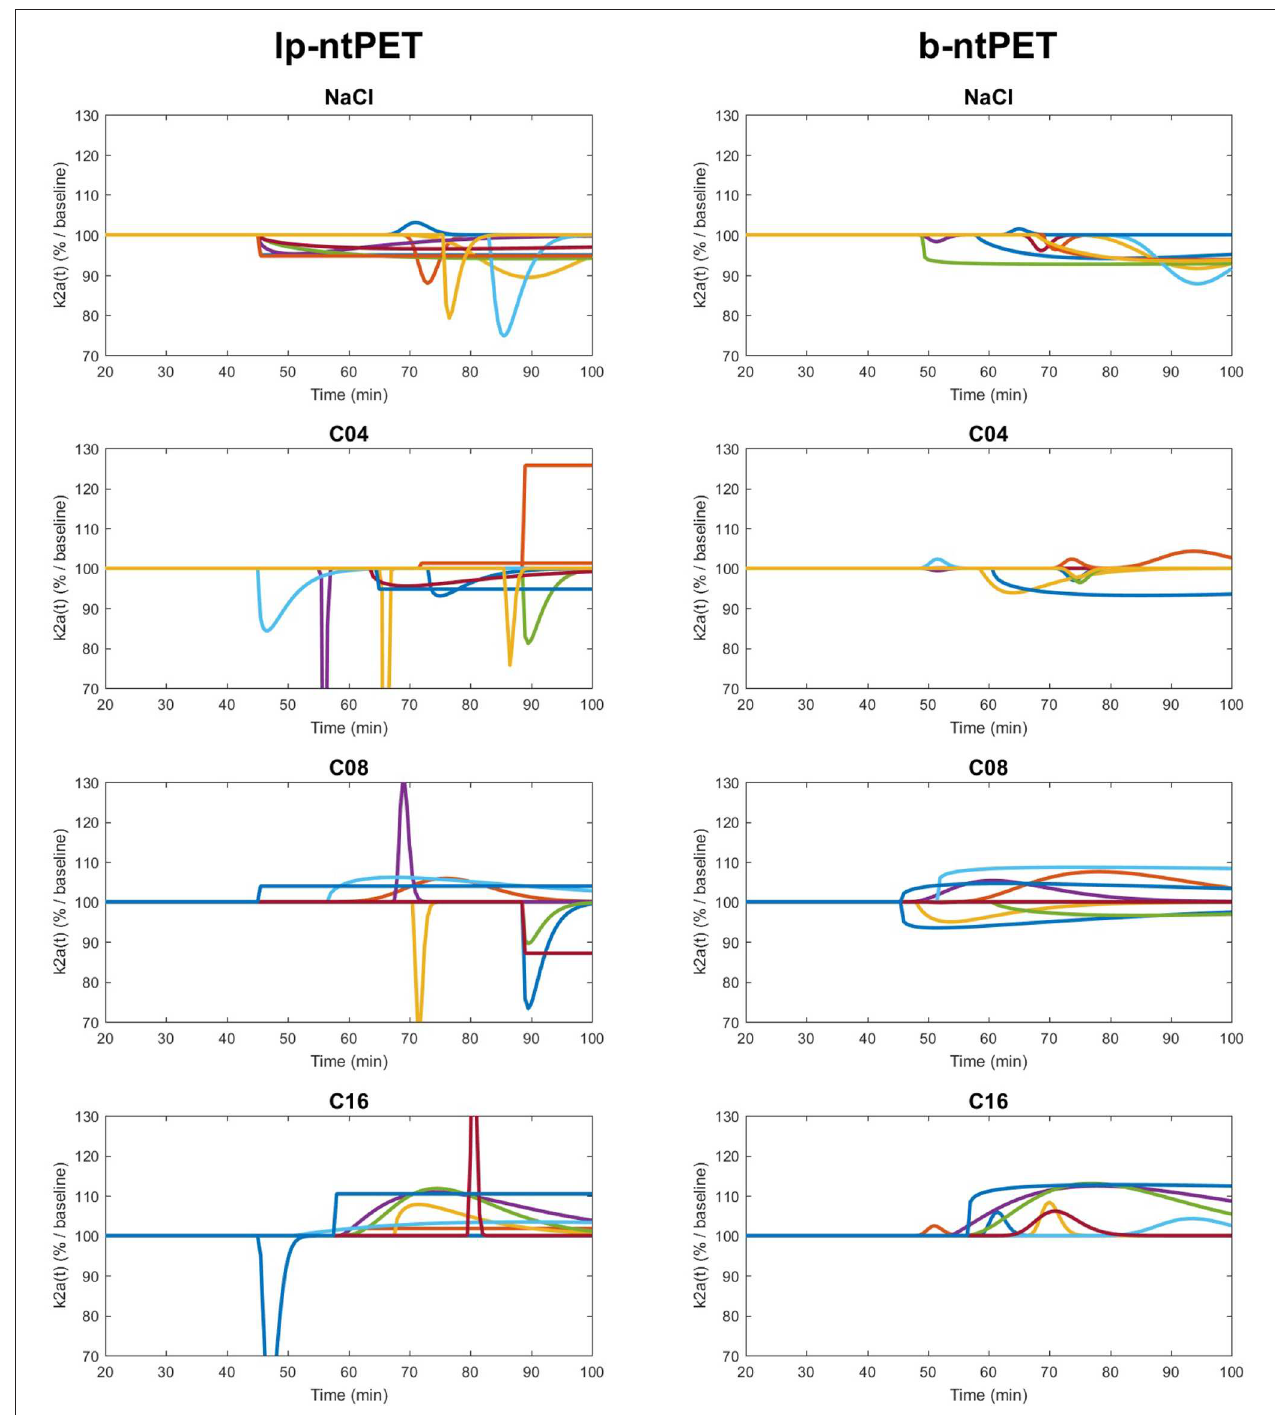
FIGURE 12 | Individual k % baseline 2 a ( t ) curves (left and right regions for each cat), obtained with lp-ntPET (Left) and b-ntPET (Right) approaches, for each condition. The different acquisitions are represented with different colors. Both hippocampus left and right are presented.